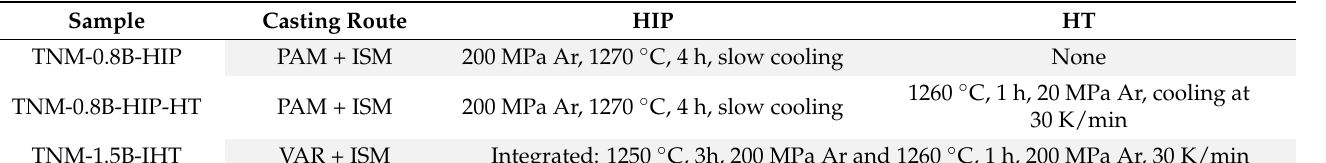
Table 2. Manufacturing and processing routes of the creep tested samples.